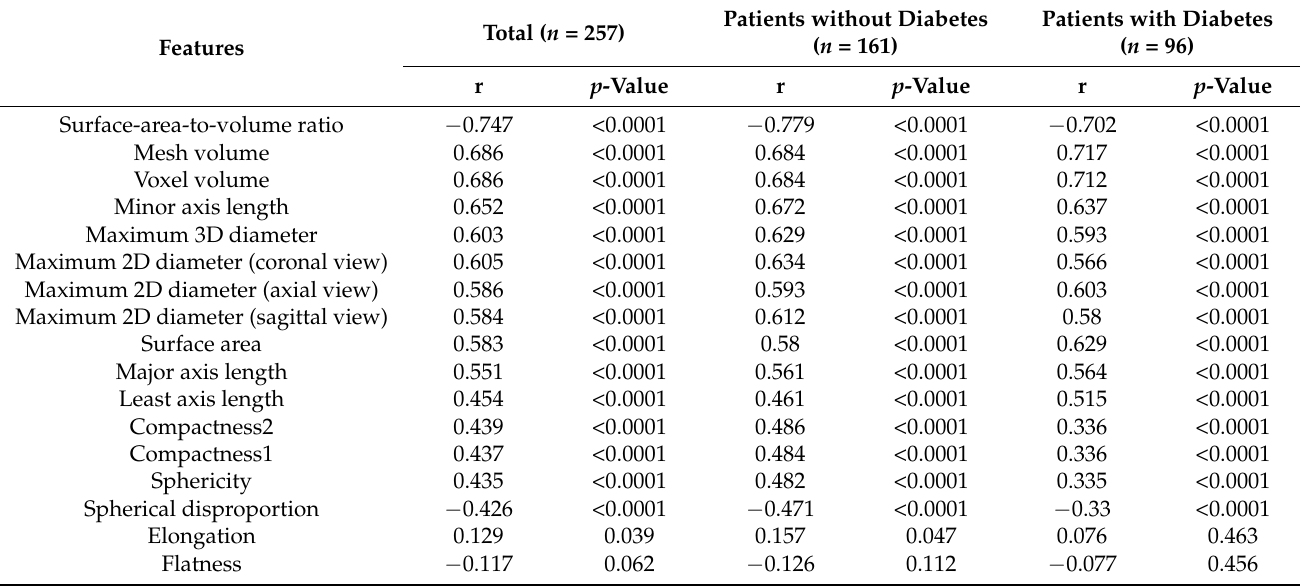
Table 2. Correlation of morphological features with